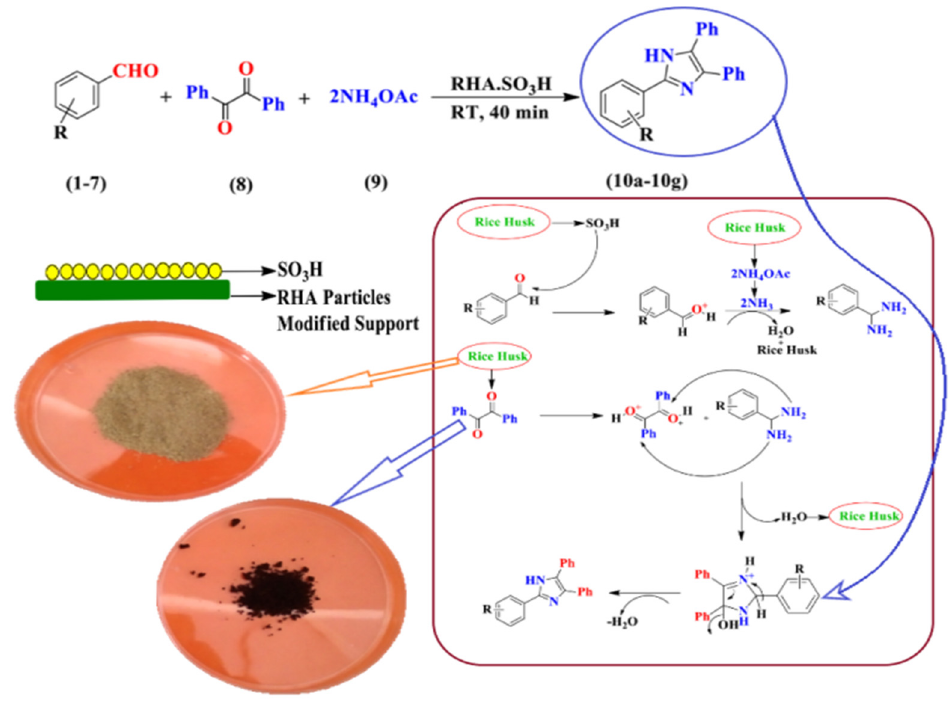
Figure 5. Scheme for the synthesis of Imidazole with RH ash. Reprinted with permission from Ref. [30]. Copyright 2022, Elsevier.